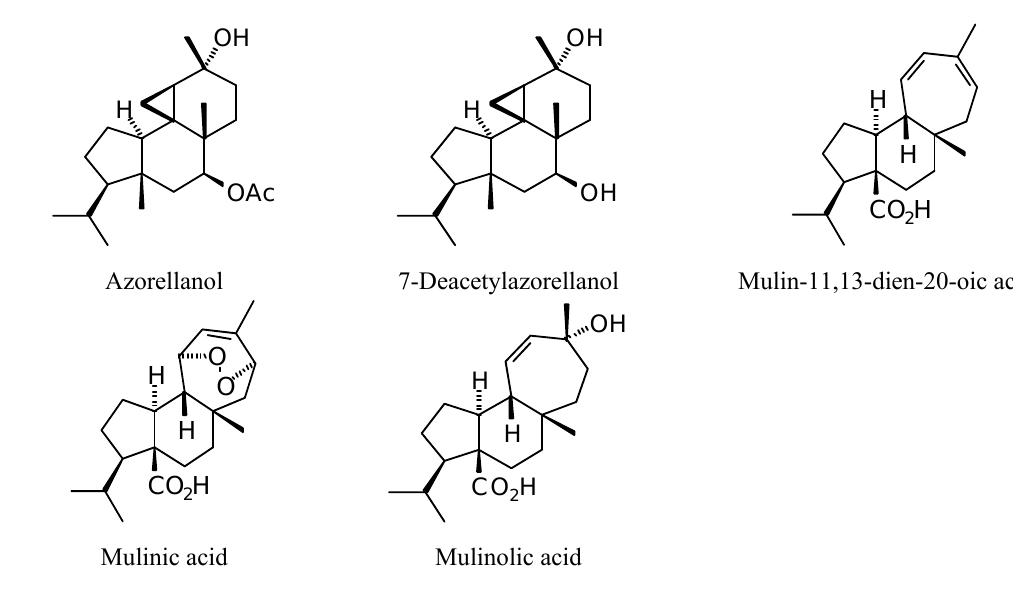
Figure 17. Mulinane diterpenoids examined in this study.